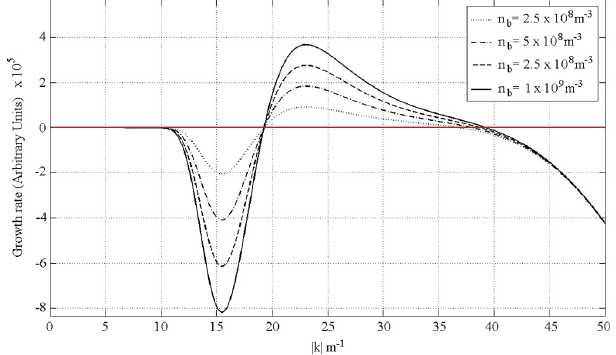
Fig. 2. Growth rate (Diaz et al., 2010, Eq. 7) for the four electron beam densities presented in Table 2 (Sect. 3.1).